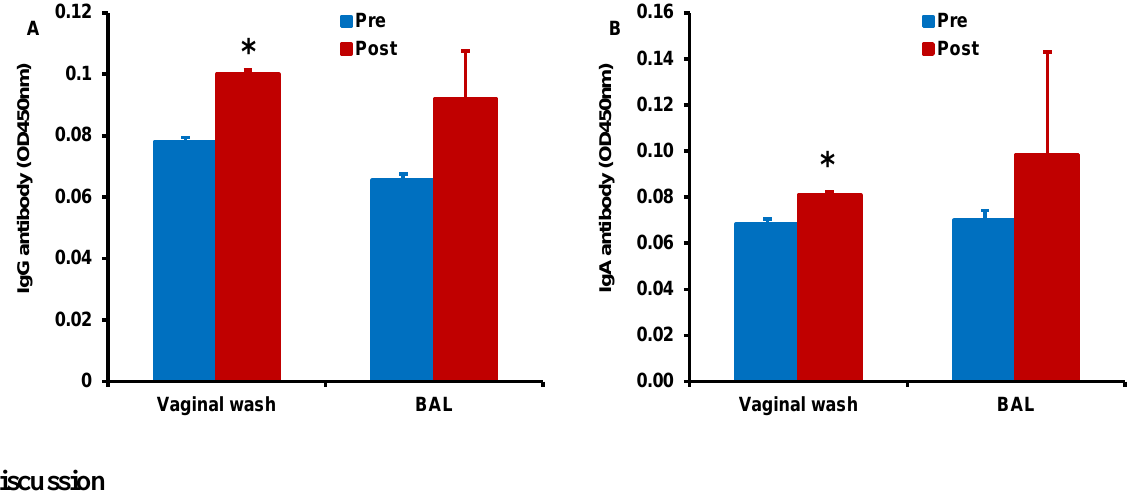
Figure 8. Enhancement of antigen-specific antibody responses after sublingual immunization with HD-Ad HIV envelope in the presence of α-GalCer adjuvant: Vaginal wash and BAL samples collected from monkeys prior to and after immunization (pre and post, respectively) by the sublingual route with the HD-Ad vector encoding the HIV-1 envelope protein (10 11 vp) along with α-GalCer (125 µg) were analyzed by the standard ELISA for IgG ( A ) and IgA ( B ) antibodies specific to the HIV envelope protein gp160. Levels of both types of antibodies were significantly higher in the vaginal wash samples when compared to those in pre-immune samples as determined by the student’s t test ( * p <